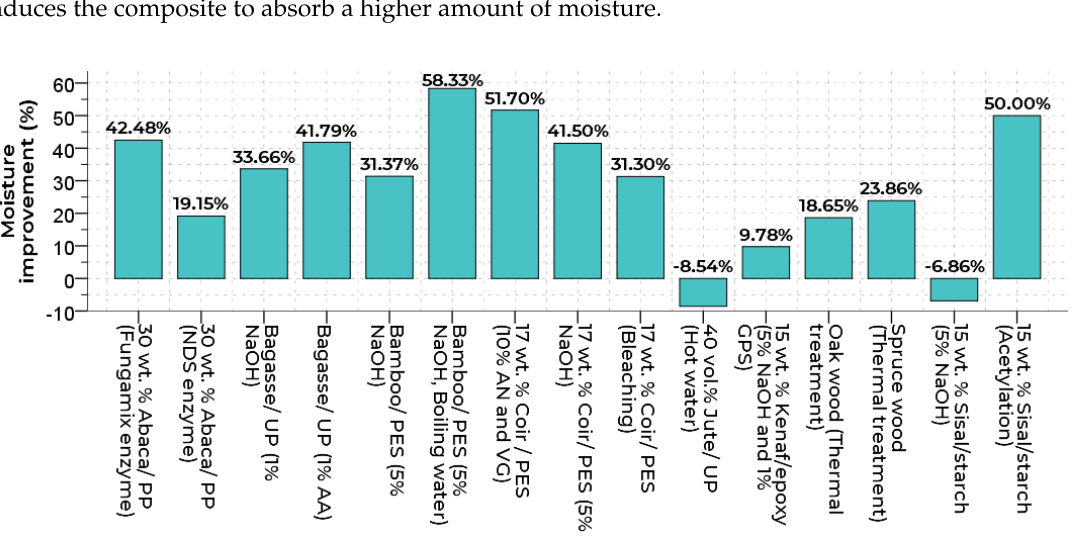
Figure 3. The effect of different treatment methods on the improvements attained on the moisture absorption behavior of natural composites. 30 wt. % Abaca/PP (1920 h) [84], Bagasse/UP (720 h) [85], Bamboo/PES (1440 h), immersion in boiling water (2.0 h) [86], 17 wt. % Coir/PES (1440 h) [87], 40 vol. % Jute/UP (960 h) [88], 15 wt. % Kenaf/epoxy (816 h) [81], Oak wood (168 h) [89], Spruce wood (168 h) [89], 15 wt. % Sisal/starch [90].